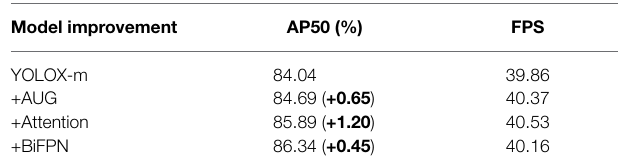
TABLE 2 | Accuracy and performance of ablation experiments with the improved YOLOX-m